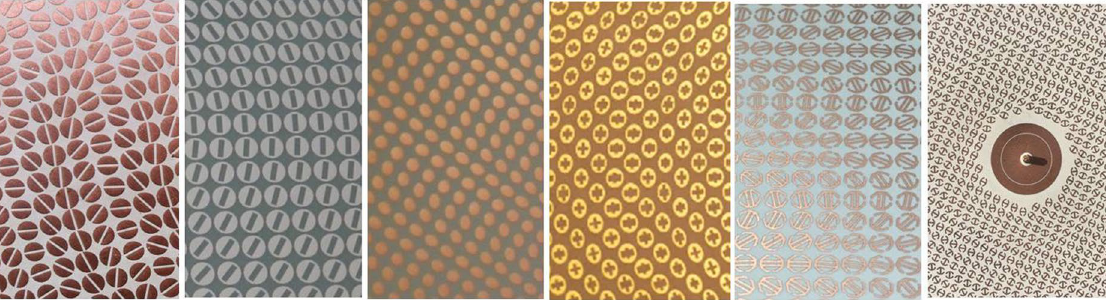
Figure 1. Examples of textured layout for implementing the MTS: ( a ) coffee bean, ( b ) patch with slot, ( c ) grain of rice, ( d ) patch with cross slot ( e ) double π (f) double anchor and details of the